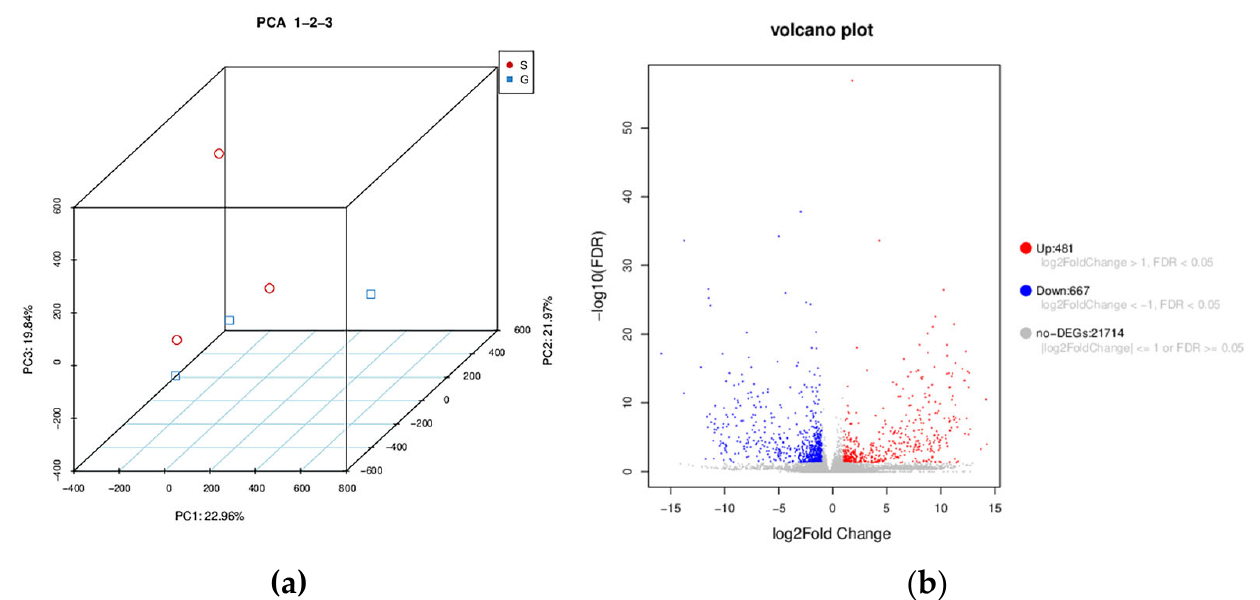
Figure 3. ( a ) Principal component analysis showing statistical clustering of gene expression in gregarious and solitary second-day sixth instar oriental armyworm ( Mythimna separata ) larvae. Red indicates solitary type and blue gregarious type. ( b ) Volcano plot showing the effect of high population density on gene expression in armyworms.